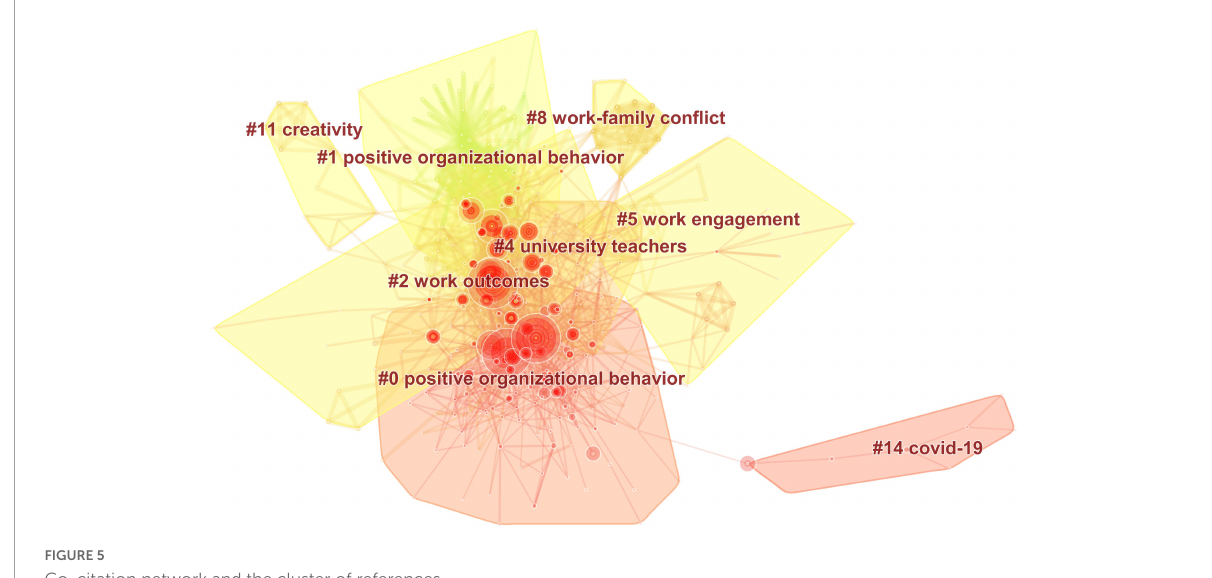
FIGURE5 Co-citation network and the cluster of references.